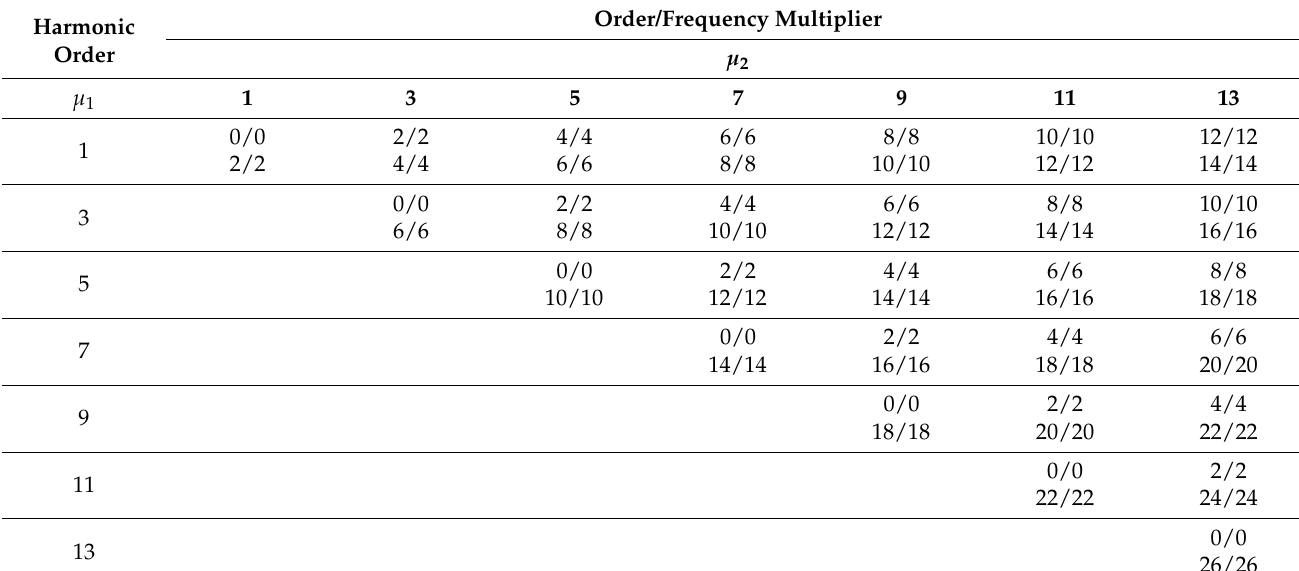
Table 3. The permanent magnetic field alone generates radial electromagnetic